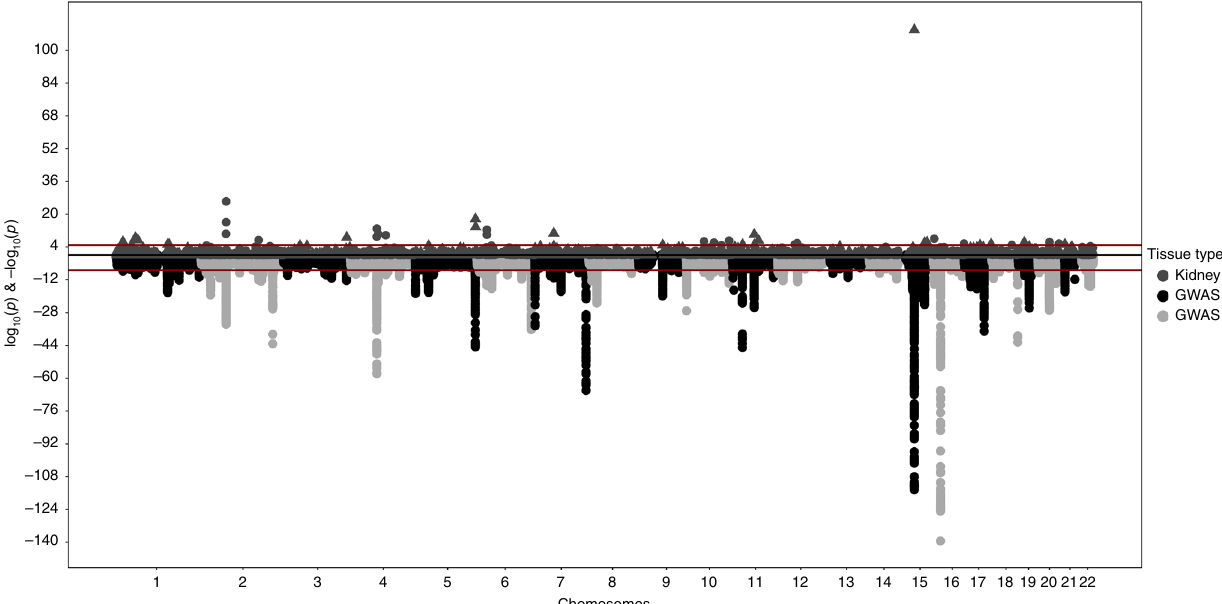
Fig. 2 Juxtaposed mirror plots for S-PrediXcan and GWAS for eGFR. Log 10 ( p -values) for associations between genetically predicted gene expression (GPGE) analyses with eGFR in kidney tissue are juxtaposed with – log 10 ( p -values) from transethnic GWAS analyses (triangles represent odd numbered chromosomes, circles represent even numbered chromosomes). GWAS plot represents transethnic discovery meta-analysis results (chromosomes alternate by light gray and black